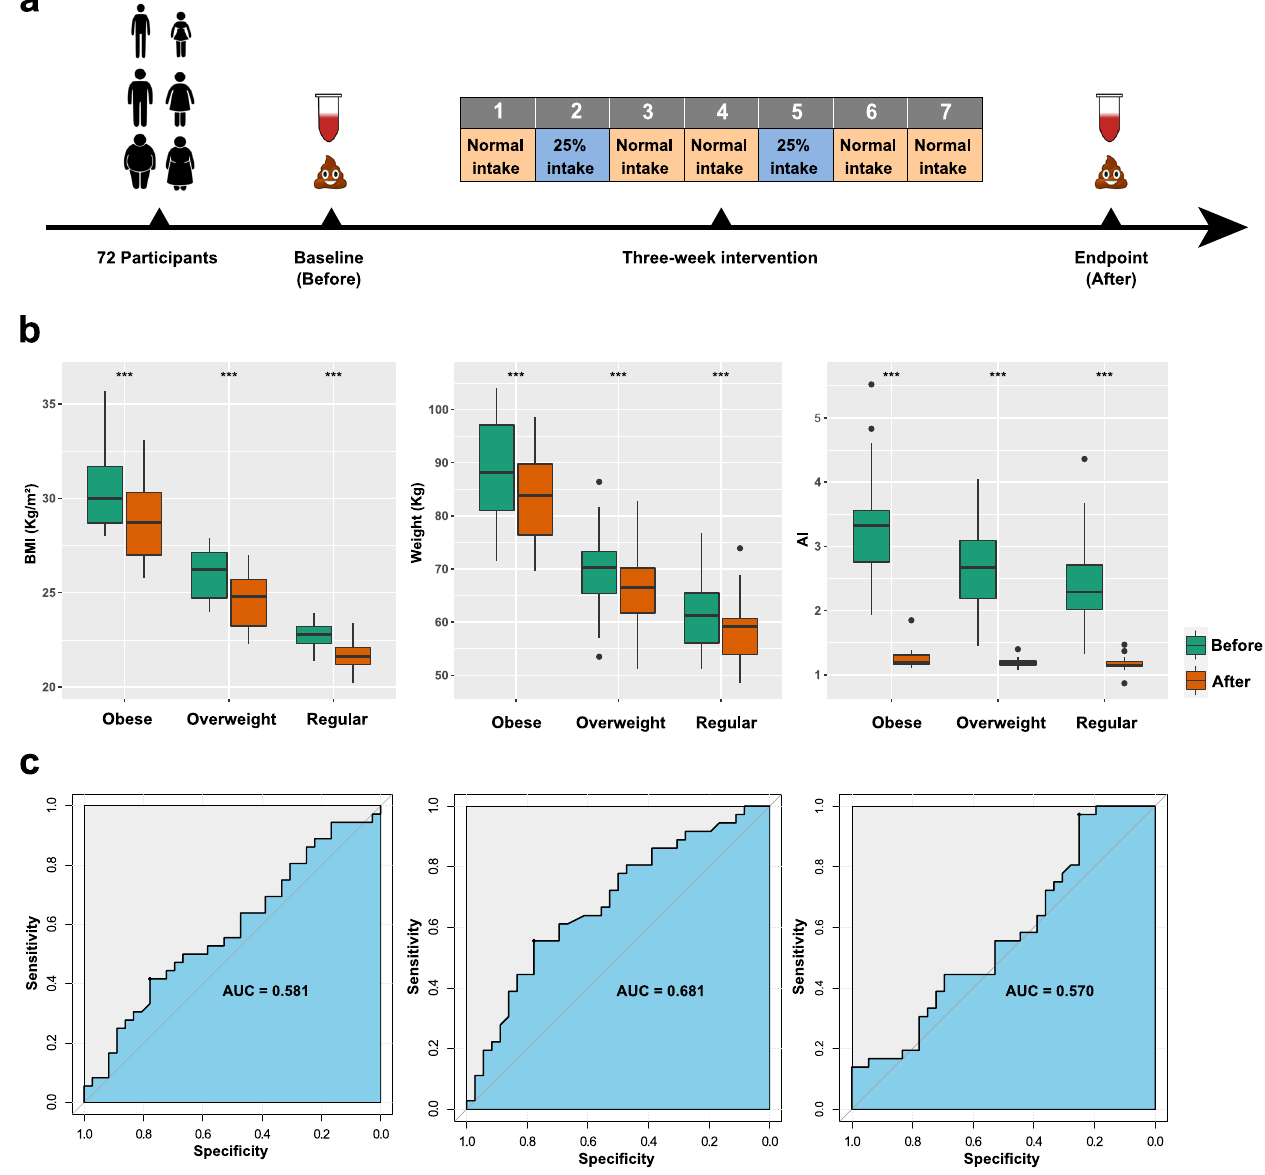
Fig. 1 Study design and clinical improvements after the three-week IF intervention. a Schematic diagram of this study. For the fi ve non- fasting days per week, meal replacement powders were arranged as a staple food for dinner, and participants were instructed to eat ad libitum (labeled as “ Normal intake ” ). For the two discontinuous fasting days, the energy intake was set on 500 – 600 kCal (about 25% of participants ’ normal intake), provided by meal replacement powders and protein sticks. b Body mass index (BMI), weight, and atherosclerosis index (AI) showed signi fi cant improvement (*** represents adjusted p < 0.001, paired Wilcoxon test) after the intervention. The improvements were uniform among participants with different levels of BMI. Bounds of boxes represent the fi rst quartiles (Q1) and the third quartiles (Q3) respectively, center lines represent the median values, and the whiskers are ranged from Q1 – 1.5 × (Q3 – Q1) to Q3 + 1.5 × (Q3 – Q1). c Receiver operating characteristic (ROC) curve of random forest classi fi ers based on the relative abundances of metagenome-assembled genomes (MAGs) before the intervention. Area under the curve (AUC) = 0.570, 0.681, and 0.582,